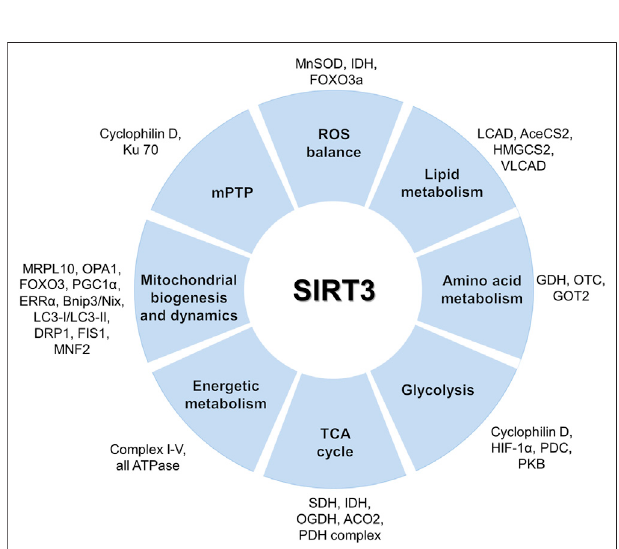
FIGURE 2 | Mitochondrial functions and targets of SIRT3. SIRT3 activates various substrates via deacetylation to maintain metabolic homeostasis including substrates involved in the TCA cycle, glycolysis, amino acid metabolism, lipid metabolism, ROS balance, and mitochondrial